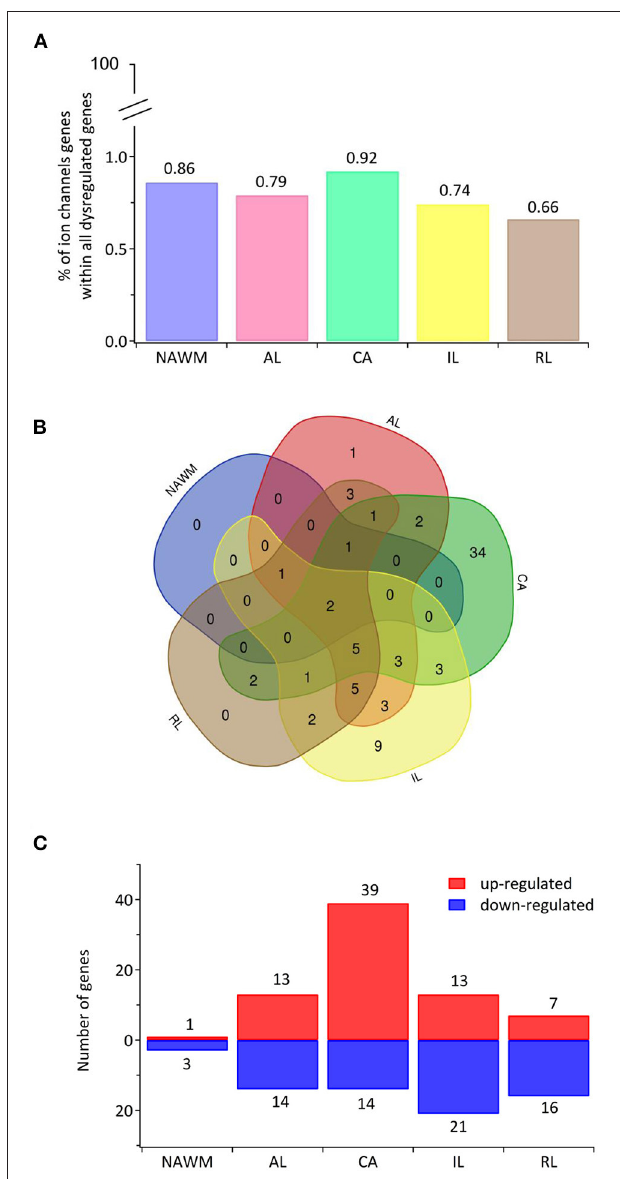
FIGURE 1 | The transcriptional landscape of ion channels in different types of white matter brain lesions from patients with secondary progressive multiple sclerosis. (A) The percentage of significantly differentially expressed genes coding for ion channels among all dysregulated genes and within each lesion type [chronic active (CA), active (AL), inactive (IL), and remyelinating (RL)] and normal-appearing white matter (NAWM) compared to control white matter are indicated. (B) The Venn diagram shows the number of lesion-specific differentially expressed genes coding for ion channels and the number of overlapping genes among the lesion types. (C) The number of significantly differentially upregulated (red) and downregulated (blue) genes in each type of while matter lesion and NAWM compared to control white matter are